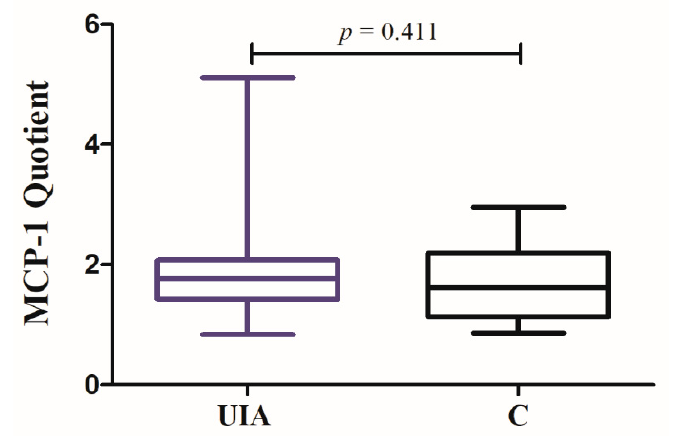
Figure 5. MCP-1 Quotient in unruptured intracranial aneurysm (UIA) patients compared to control group (C).